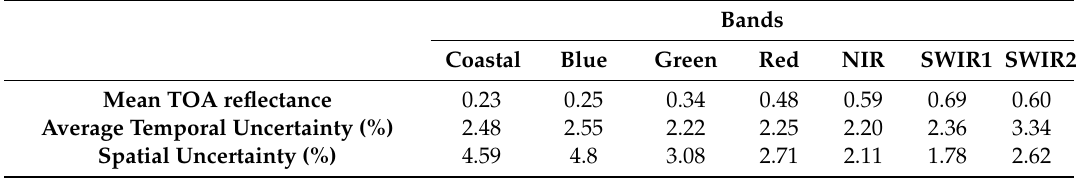
Table 1. Mean TOA reflectance and uncertainty of Cluster 13 (Initial analysis found in [17]). Bands Coastal